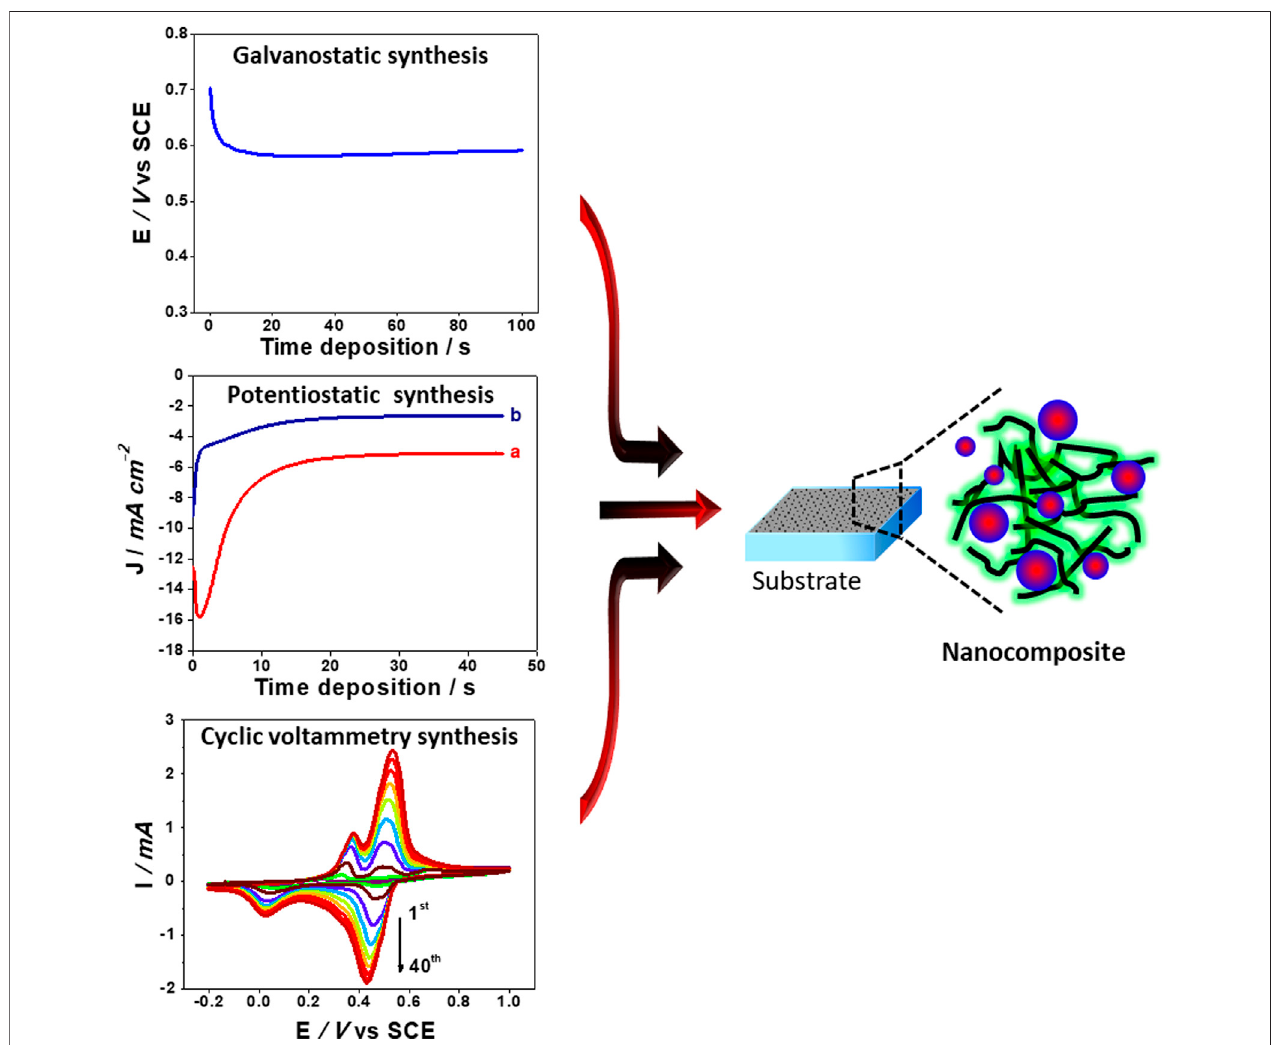
FIGURE 4 | Electrochemical routes to synthesis of conducting polymer — metal nanostructures composites.